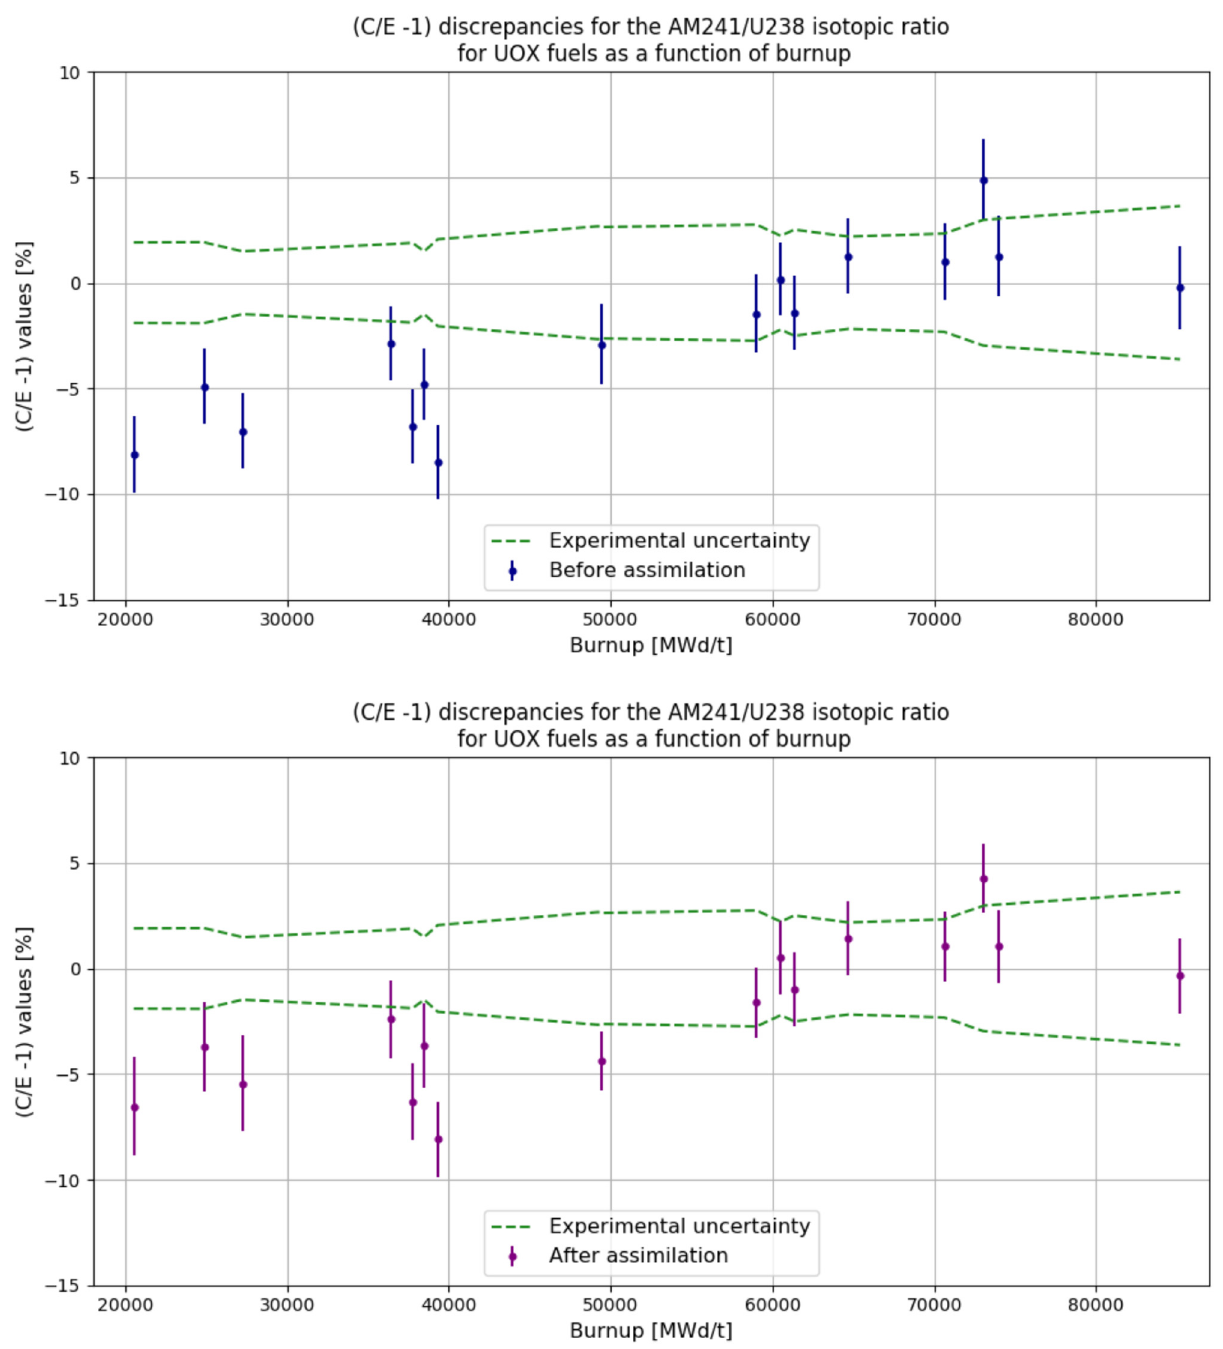
Fig. 5. Evolution of the calculated-to-experimental discrepancies before and after integral data assimilation for the 241 Am/ 238 U isotopic ratio in UOX